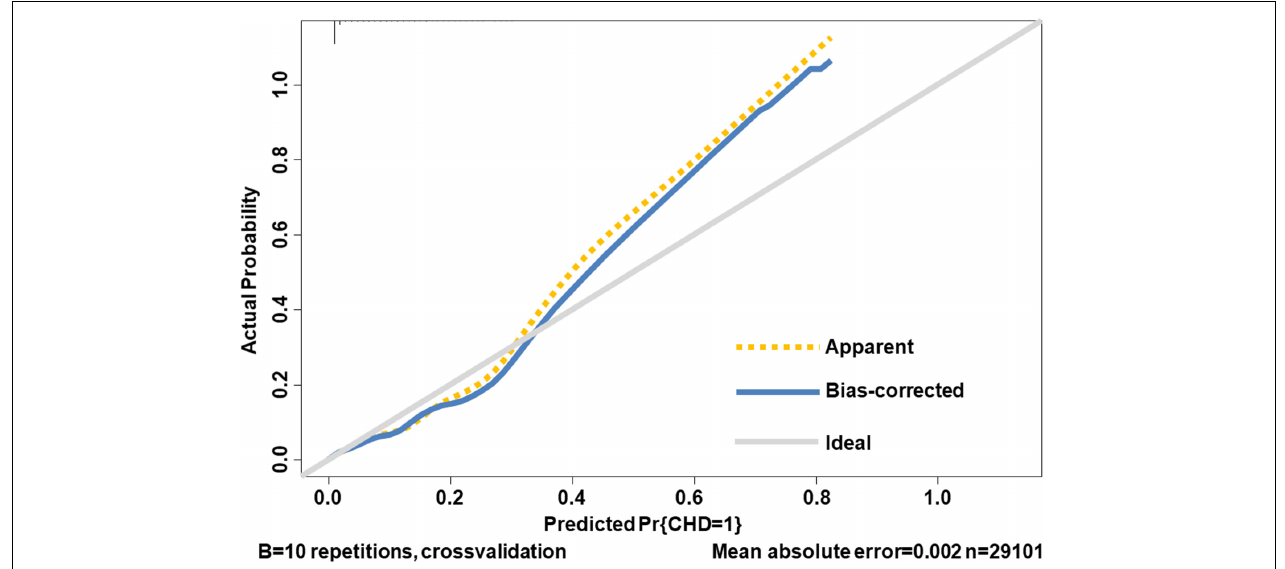
FIGURE 3 | The calibration curve of internal validation. The 45-degree long gray solid line represents an ideal prediction, the brown dotted line represents the current nomogram we constructed, and the blue solid line is the bias-corrected fitted line of the nomogram using a 10-fold cross-validation method. The closer the blue solid line is to the ideal line, the better the calibration of the nomogram is.